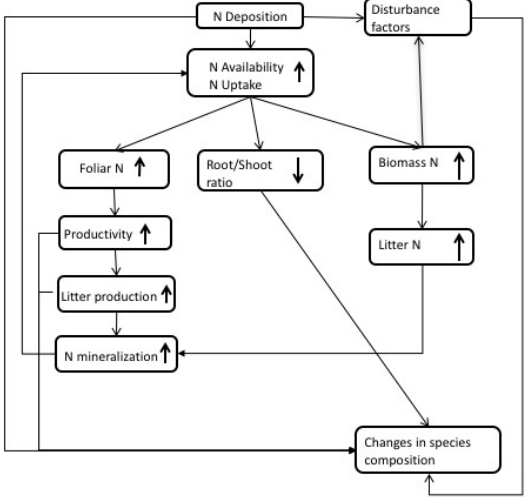
Figure 1. Effects of N deposition on ecosystems, based on the concepts of Bobbink et al. [7]. Up arrows represent an increase, and down arrows represent a decrease. Three main pathways exist: changes in foliar or leaf N, changes to biomass partitioning, and increases in biomass N. Changes in leaf or plant N generally lead to a positive feedback by increasing N in the litter pool. Changes in the partitioning of biomass can lead to changes in competition for resources that will ultimately affect species distribution. In general, the impacts of N deposition occur over short timescales (<5 years), while changes to species composition and disturbance occur over longer timescales [7].